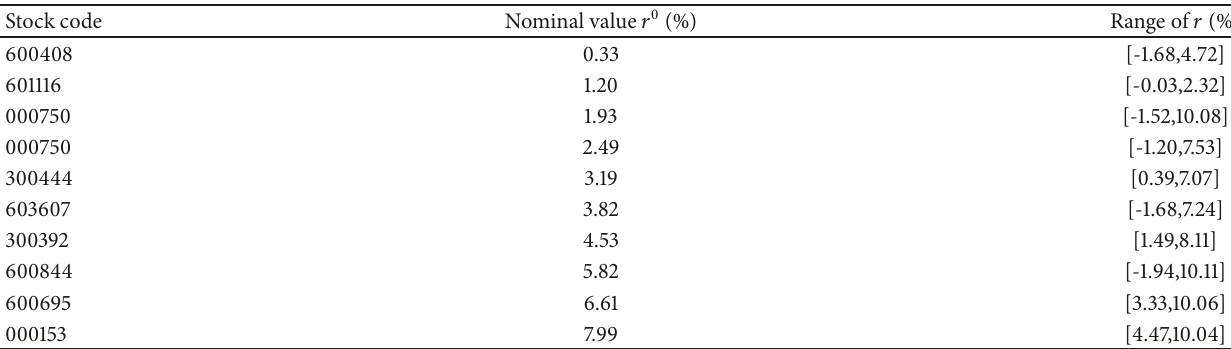
Table 1: Descriptive statistics for the return rates of 10